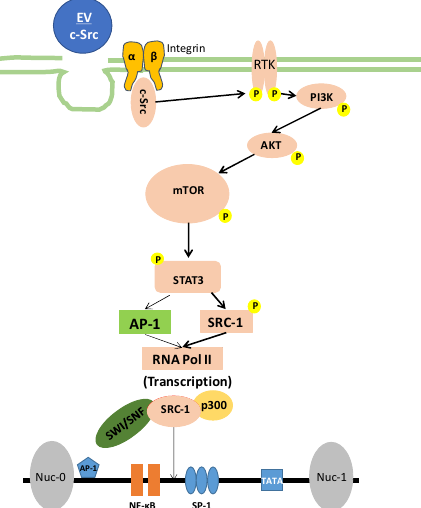
Figure 7. Proposed model for EV activation of latent HIV-1. Uninfected EVs from healthy cells are taken up by HIV-1 latent infected cells, leading to the phosphorylation and activation of receptor tyrosine kinases (RTK) by c-Src. RTK then activates PI3K, which in turn activates AKT. Following activation, AKT phosphorylates mTOR, resulting in the phosphorylation and activation of the transcription inducer, STAT3. STAT3 then recruits the cofactor SRC-1, before translocating to the nucleus and promoting HIV-1 transcription by recruiting p300 (promotes chromatin remodeling). NF- κ B and RNA Pol II increase loading onto the HIV-1 promoter, resulting in the transcription of latent HIV-1.